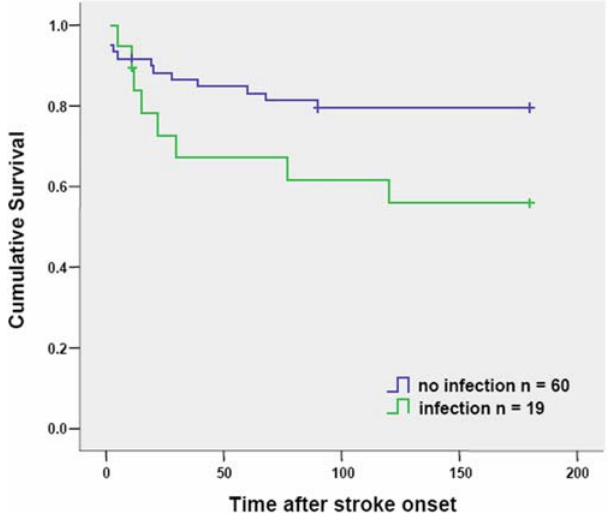
Figure 4. Kaplan-Meier curves of survival in patients with and without infections. Crosses indicate time points when patients were lost to follow-up (‘censored’; n=7, infection n=1, no infection n=6). Seven (no infection n=5, infection n=2) of 79 patients (8.9%) died within 11 days after stroke onset. Within 6 month after stroke 13 (infection n=6, no infection n=7) of 72 patients (18.1%) died.